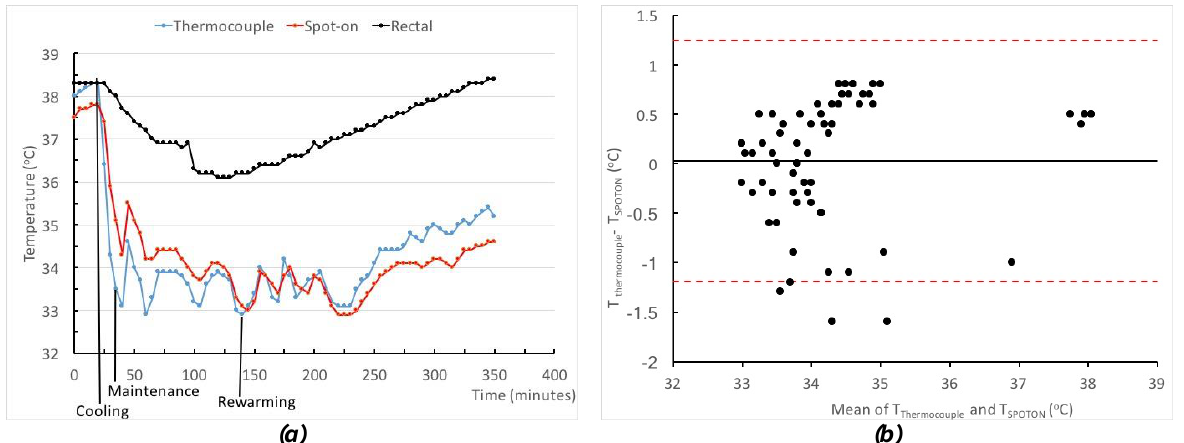
Figure 4. (a) Measured brain, rectal and esophageal temperature over time during baseline, cooling and rewarming phase. Brain data were obtained from thermocouple needle probe and SpotOn temperature monitoring system at the center of forehead (location #2). (b) Bland-Altman plot of two brain temperature methods. The dotted line shows the mean difference and dash-dotted lines show the limits of agreement (mean ± 2